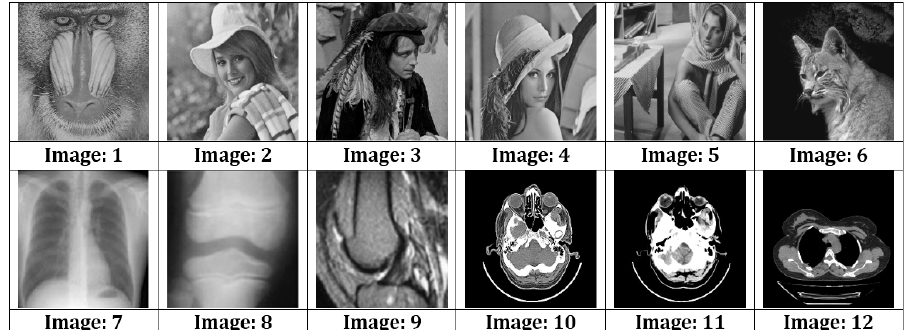
Figure 4. Various test images.